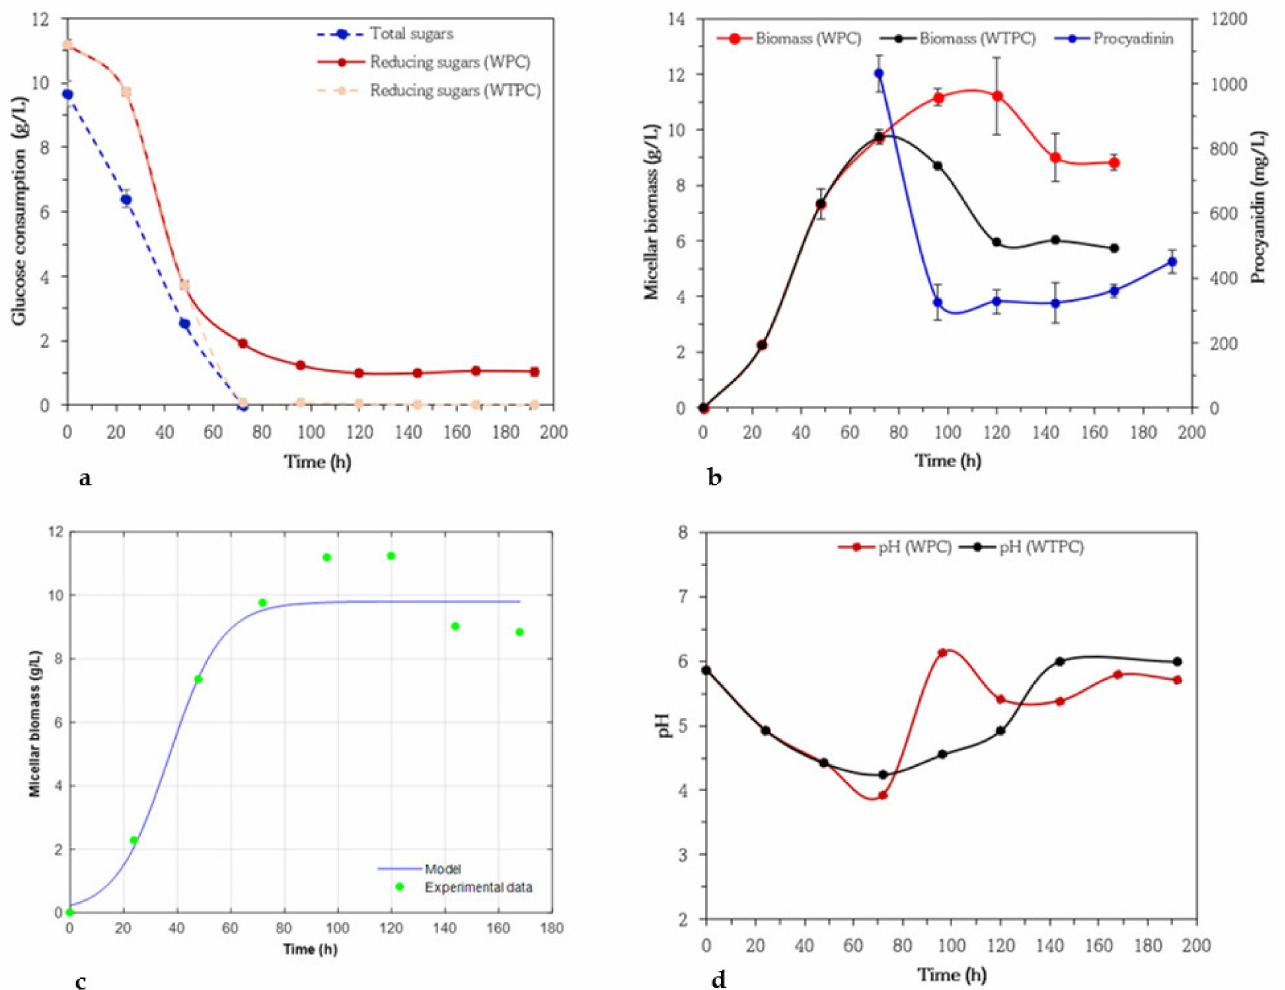
Figure 4. Variation of glucose concentrations by anthrone and 3,5 dinitrosalicylic acid (DNS) methods ( a ), micellar biomass in culture medium with (WPC) and without addition of procyanidins (WTPC) when glucose was below 3.0 g/L (stationary phase), and changes in procyanidin concentrations ( b ) in submerged cultures of Aspergillus niger PSH. Micellar biomass production by Aspergillus niger PSH in submerged cultures using basic medium of salts and glucose (10 g/L) and with addition of procyanidin when glucose was below 3.0 g/L (stationary phase). Symbols represent experimental data. Solid lines represent calculated data ( c ), Evolution of pH in submerged cultures of Aspergillus niger PSH in medium with (WPC) and without (WTPC) addition of procyanidins when glucose was below 3.0 g/L (stationary phase) ( d